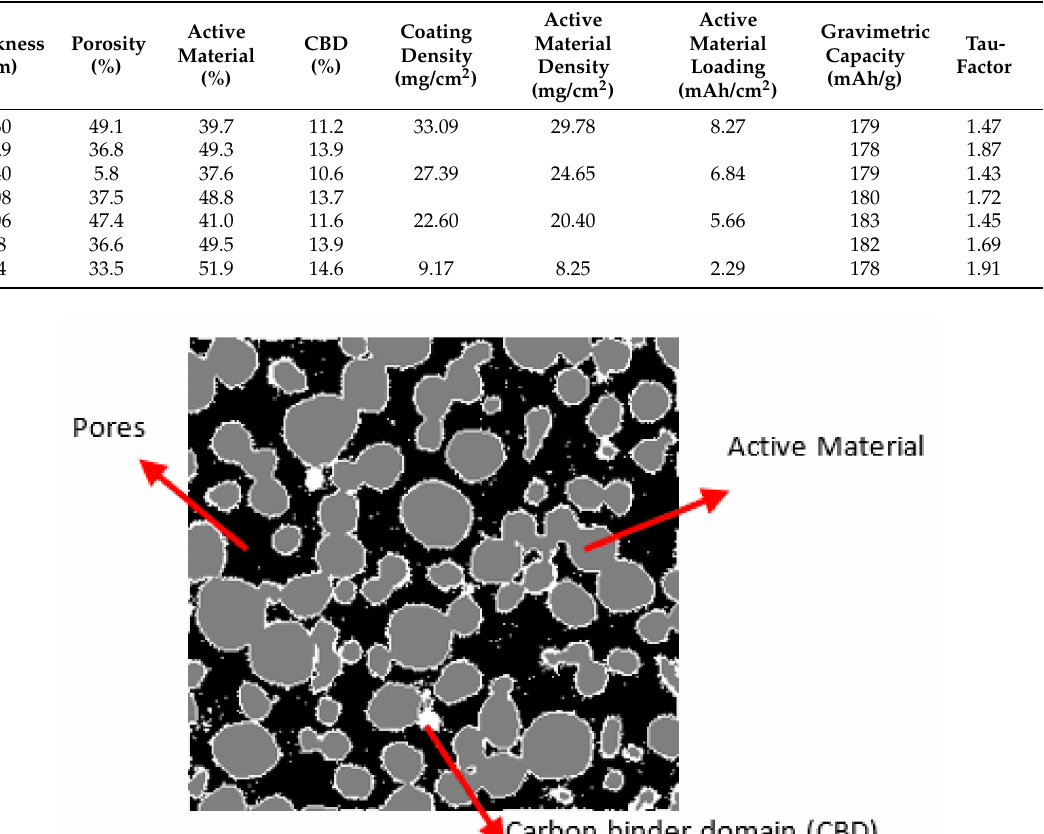
Figure 2. The three-phase microstructure used for this